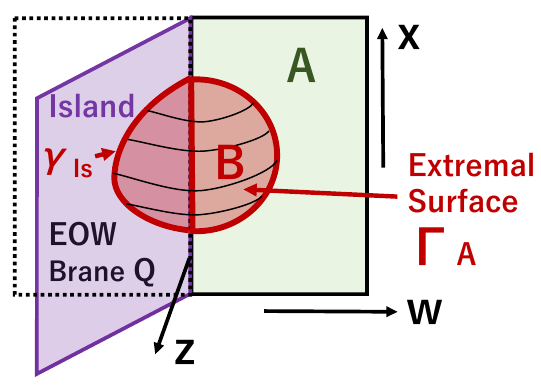
Figure 7 . Calculation of holographic entanglement entropy in